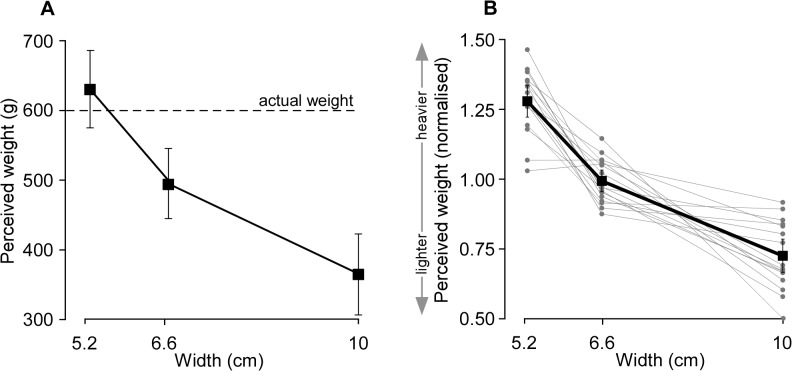
The effect of canister width on perceived weight of an unseen lifted object (experiment 2).A, shows the mean [95% CI] perceived weight of each of the three lifted canisters of the same weight (600 g) with varied widths. The perceived weight differed significantly with changes in canister width. The narrow canister felt much heavier than wide canisters (P < 0.001). Dashed line represents the actual canister weight (600g). B, shows the mean [95% CI] perceived weight of all trials for each subject normalised and presented as a ratio (perceived weight / mean perceived weight of all trials; squares). Individual data are indicated by grey circles. On average, perceived weight decreased by 42.3% from the narrowest to the widest canister although all canisters weighed 600 g (P<0.001).